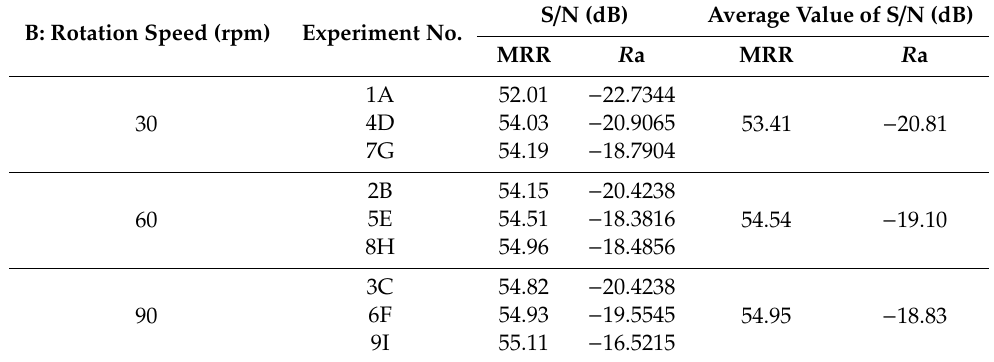
Table 4. Average value of S / N of rotation speed.